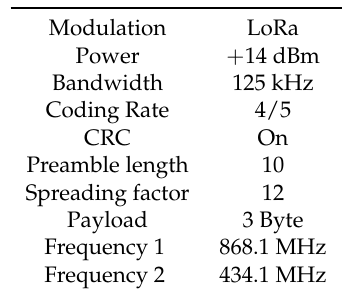
Figure 3. Detail of the 868 MHz antenna mounted on the 4 × 4 vehicle. Table 1. LoRa parameters selected for the measurements. CRC: cyclic redundancy